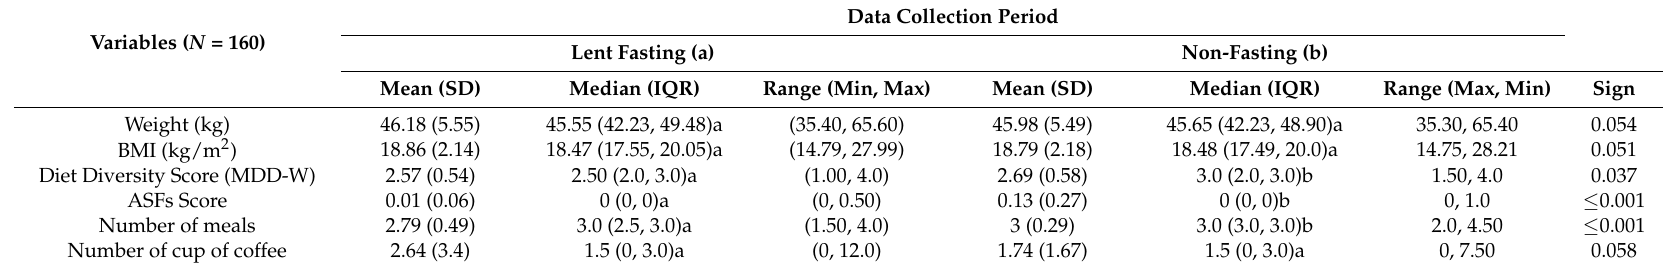
Table 6. Comparison of fasting mothers’ food consumption and anthropometric status between Orthodox lent fasting and non-fasting periods in rural Tigray, Northern Ethiopia.